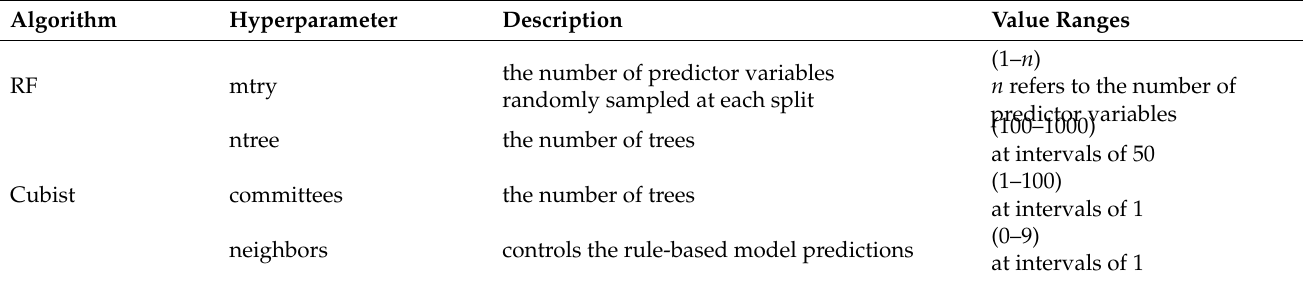
Table 5. Hyperparameter tuning ranges for four machine learning